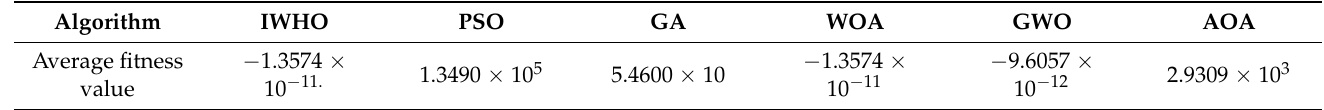
Table 2. Comparison of the average fitness values of each algorithm.